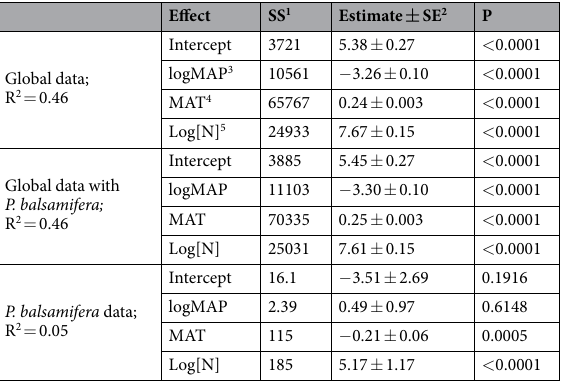
Table 1. Models of foliar δ 15 N using each of the three data sets. 1 Sum of squares. 2 Standard error. 3 Base 10 logarithm of Mean Annual Precipitation (mm). 4 Mean annual temperature (°C). 5 Base 10 logarithm of foliar nitrogen